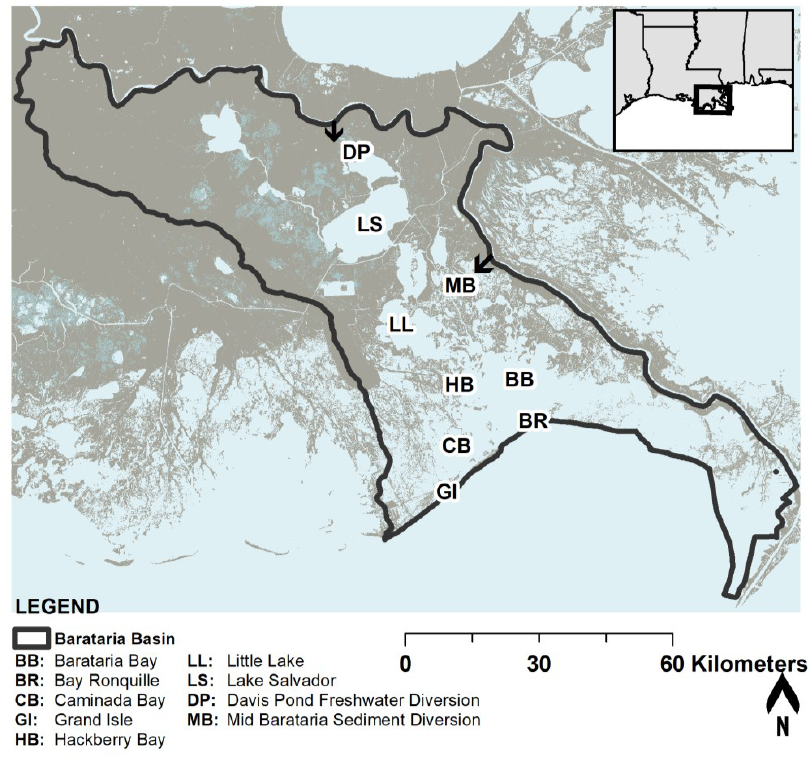
Figure 1. Barataria Basin regional extent, water bodies of interest in this analysis, and diversion locations.